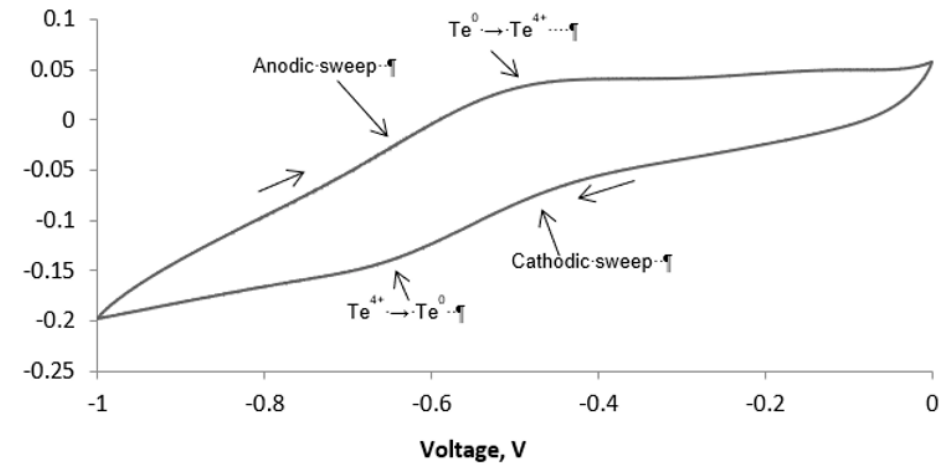
Figure 3. Cyclic voltammogram (CV) of TeCl 4 in LiCl-Li 2 O-TeCl 4 electrolyte, [Te 4+ ] –0.25 wt.%, S = 0.5 cm 2 , T − 650 °C.